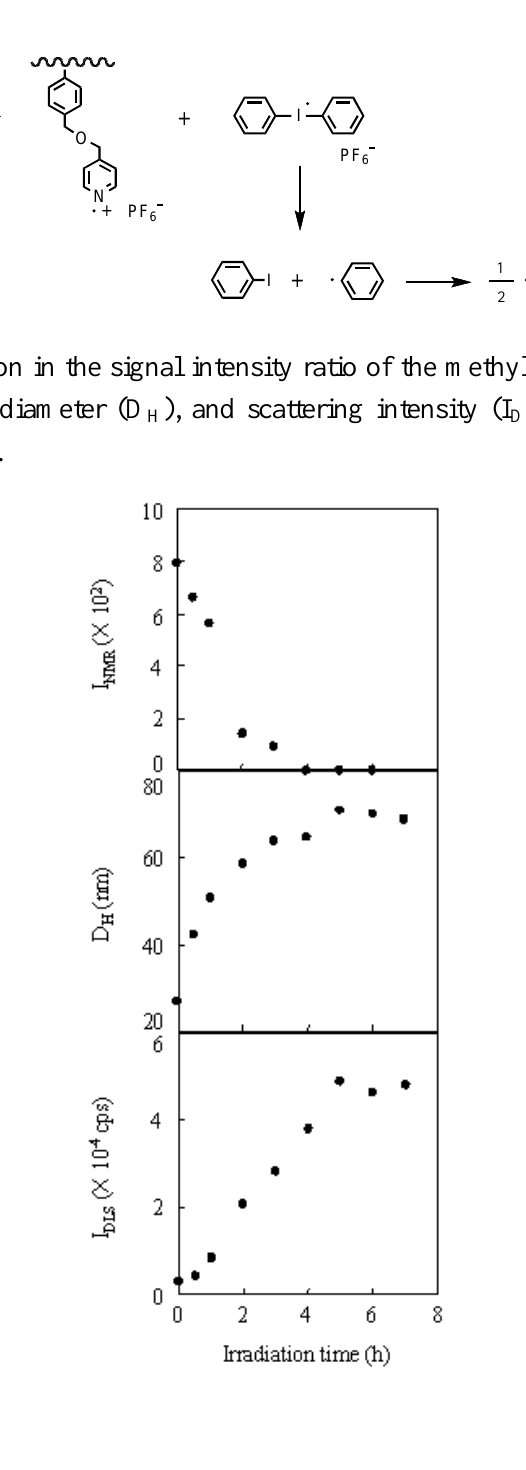
) of the copolymer in DLS